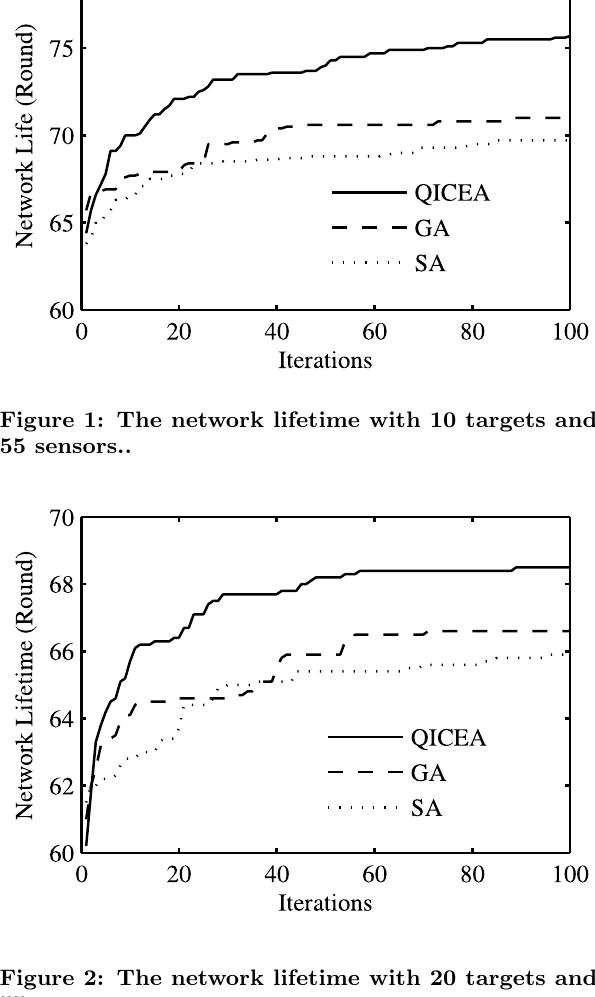
Figure 2: The network lifetime with 20 targets and 55